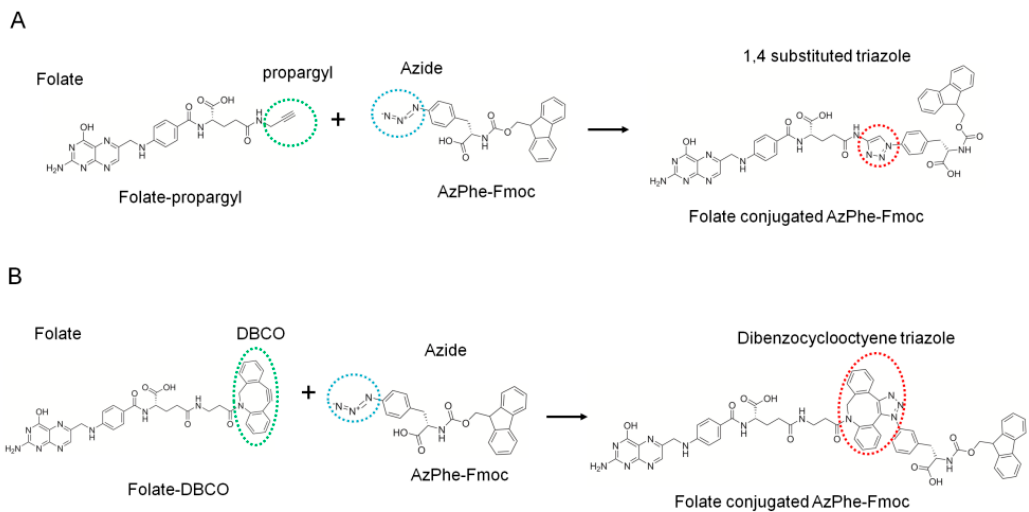
Figure 2. Schemes showing the synthesis of the folate-conjugated AzPhe-Fmoc. ( A ) The Cu(I)-catalyzed alkyne-azide cycloaddition (CuAAC) click reaction between the propargyl group (green dotted circle) and the azide group (cyan dotted circle) to conjugate folate via the triazole ring (red dotted circle). ( B ) The strain-promoted alkyne-azide cycloaddition (SPAAC) click reaction between DBCO (green dotted circle) and the azide group (cyan dotted circle) to conjugate folate via dibenzocyclooctyne triazole (red dotted circle).